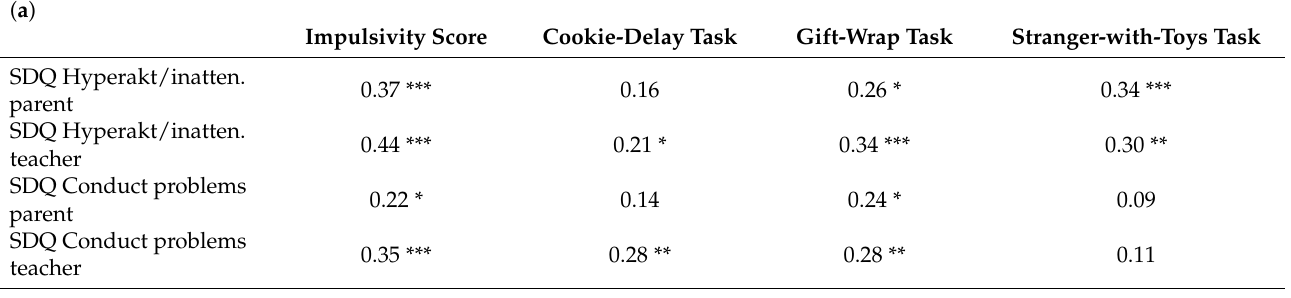
Table 2. Study 1: Associations of impulsivity with ADHD and ODD variables. ( a ). Associations of the impulsivity score and the three single tasks with ADHD and ODD symptom scores; ( b ). Associations of the impulsivity score with ADHD and ODD